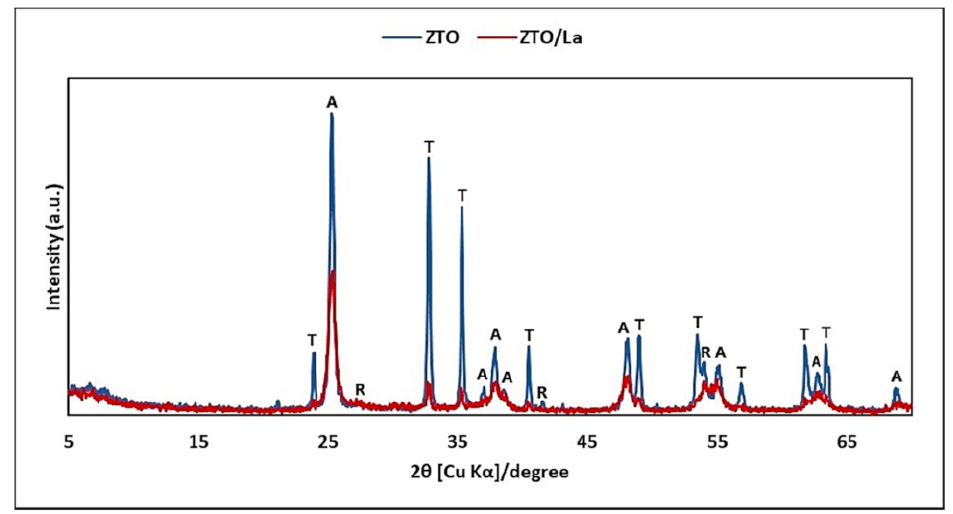
Figure 2. X-ray diffraction (XRD) pattern of ZnTiO 3 /TiO 2 (ZTO) and ZnTiO 3 /TiO 2 /La (ZTO/La). T: titanate, A: anatase, R: